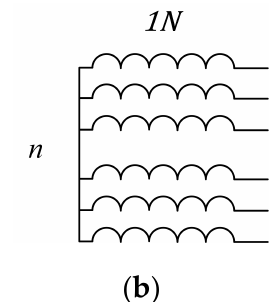
Figure 4. ( a ) Two neutral connections; ( b ) A single neutral connection for six-phase machine wind- ing. In [24], it has been shown that the connection of neutral points on the armature wind- ing significantly affects the post-fault torque that the machine could generate under faulty conditions. Moreover, the single neutral connection leads to higher torque and provides better fault-tolerant capability compared to two isolated neutral connections. In addition, the two isolated neutral connections cannot support the scenario of three open-circuit faults, and there is no possible postfault operation under this condition.